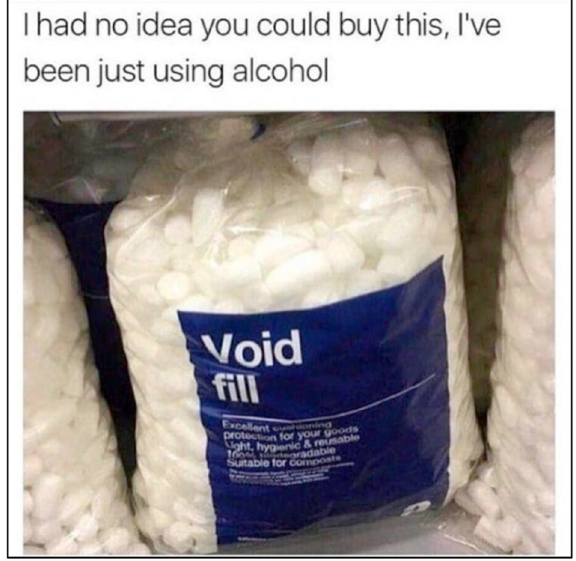
Fig. 1 Example of a mental health meme related to depression. Image gathered from the public domain each marked with either the Public Domain Mark 1.0 or CC0 1.0